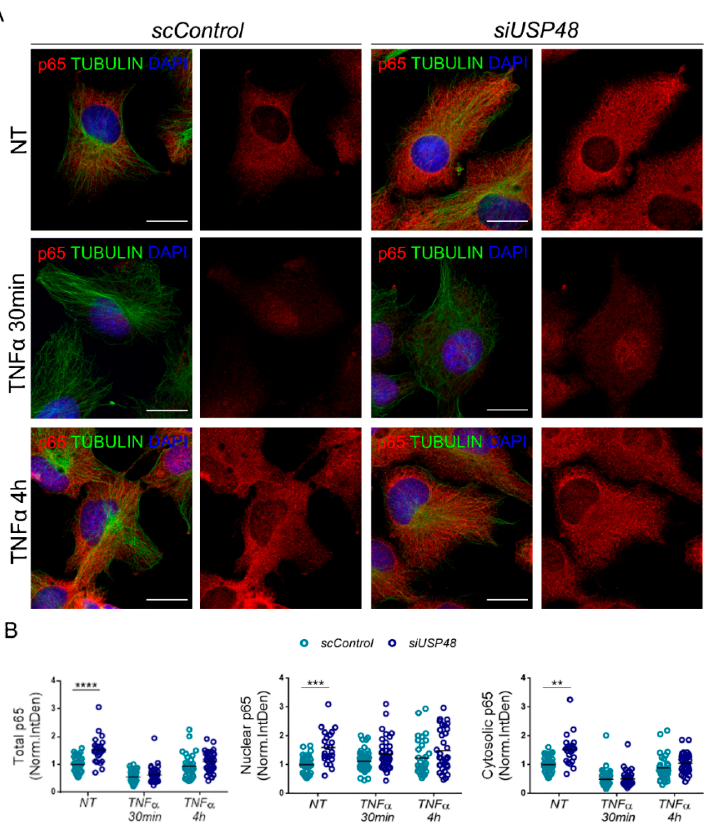
Figure 3. USP48 downregulation stabilizes p65. ( A ) Immunocytochemistry of anti-p65 (red) in USP48 knockdown hTERT-RPE1 cells at basal conditions and after treatment with TNF α at two different time points: 30 min (early response) and 4 h (late response). Cells were counterstained with anti-tubulin (green) to highlight the cell shape, and DAPI to delimit the nucleus (blue). ( B ) Total p65 (Integrated density) was significantly increased in USP48 silenced cells ( siUSP48, dark blue dots) in comparison with control cells (scControl , light blue dots), being this increase was detectable in both nuclear and cytosolic compartments. No significant changes were found following TNF α treatment at 30 min or 4 h. Scale bar: 20 μ m. Data are represented as the mean, n = 33–45 cells per condition from 3 independent experiments. Statistical analysis by two-way ANOVA: ** p -value ≥ 0.01; *** p -value ≥ 0.001; **** p -value ≥ 0.0001. As expected, TNF α treatment induced an increase in the nuclear/total p65 ratio and a decrease in the cytosolic/total p65 ratio in both early and late responses (30 min and 4 h of treatment, respectively; Figure S3). Surprisingly, we detected that in non-treated cells,